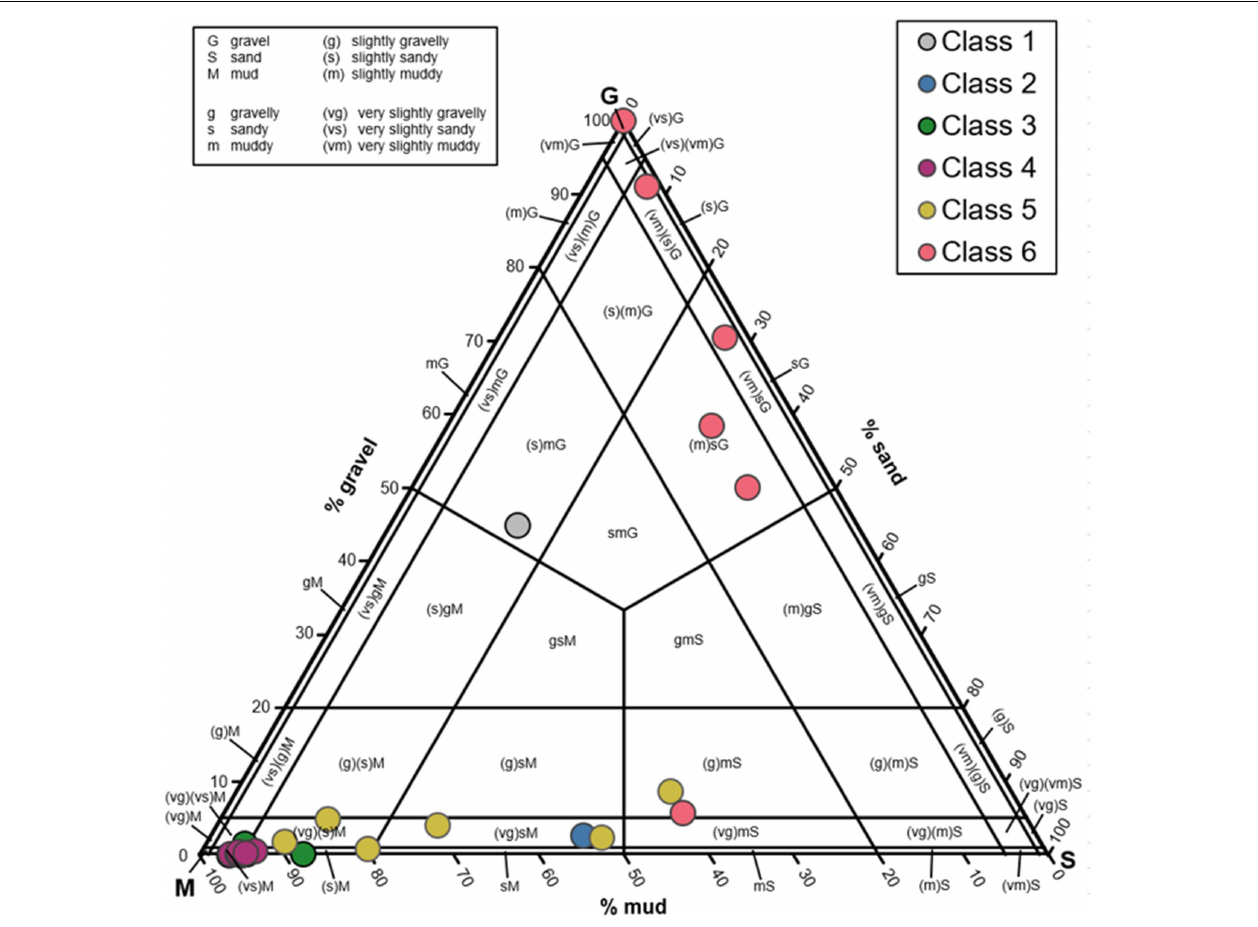
FIGURE 6 | Loch Creran particle size results plotted on a ternary diagram based on the proportion of gravel, sand and mud fractions (Blott and Pye, 2012). Individual samples are grouped by colour into classes based on the Unsupervised Iso-cluster Classification.